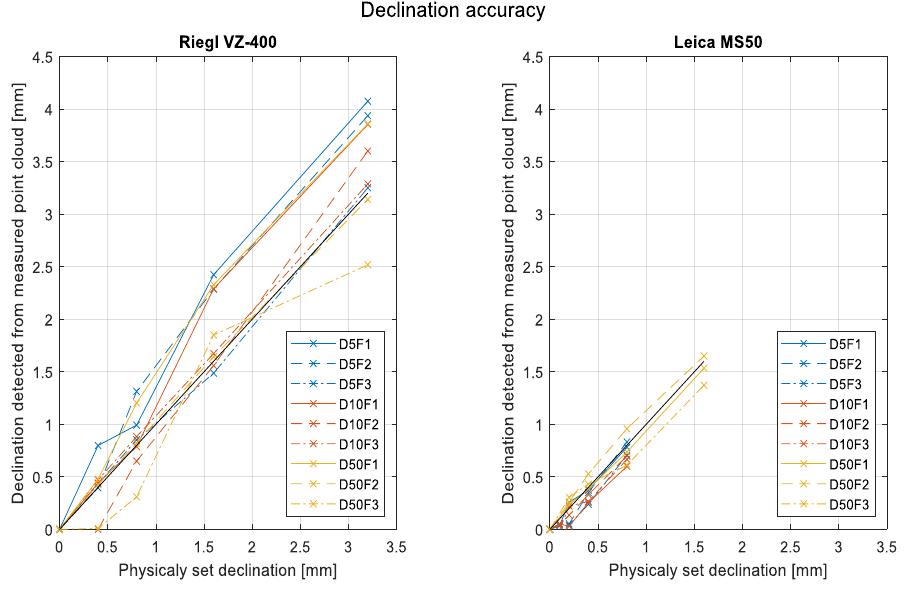
Figure 6. The accuracy of detected shifting declinations.